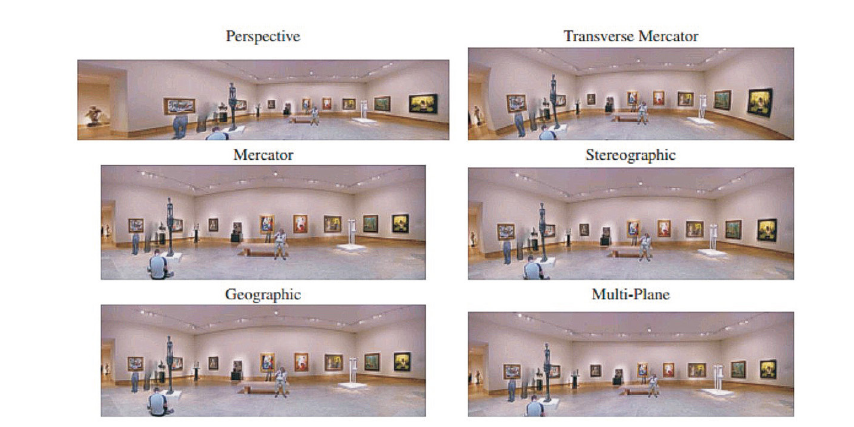
Fig. 17. Panorama in various map projections (L. Zelnik-Manor and others